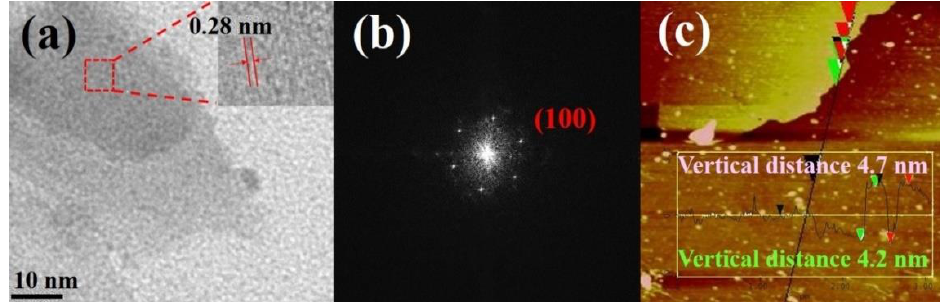
Figure 3. ( a ) TEM image of 2D CTAB-MoSe 2 prepared by liquid phase exfoliation (LPE). The inset shows its HRTEM image ( b ) The selected area electron diffraction pattern (SAED). ( c ) The atomic force microscopy image of as-obtained 2D CTAB-MoSe 2 and the corresponding height profile along the black line in the image.